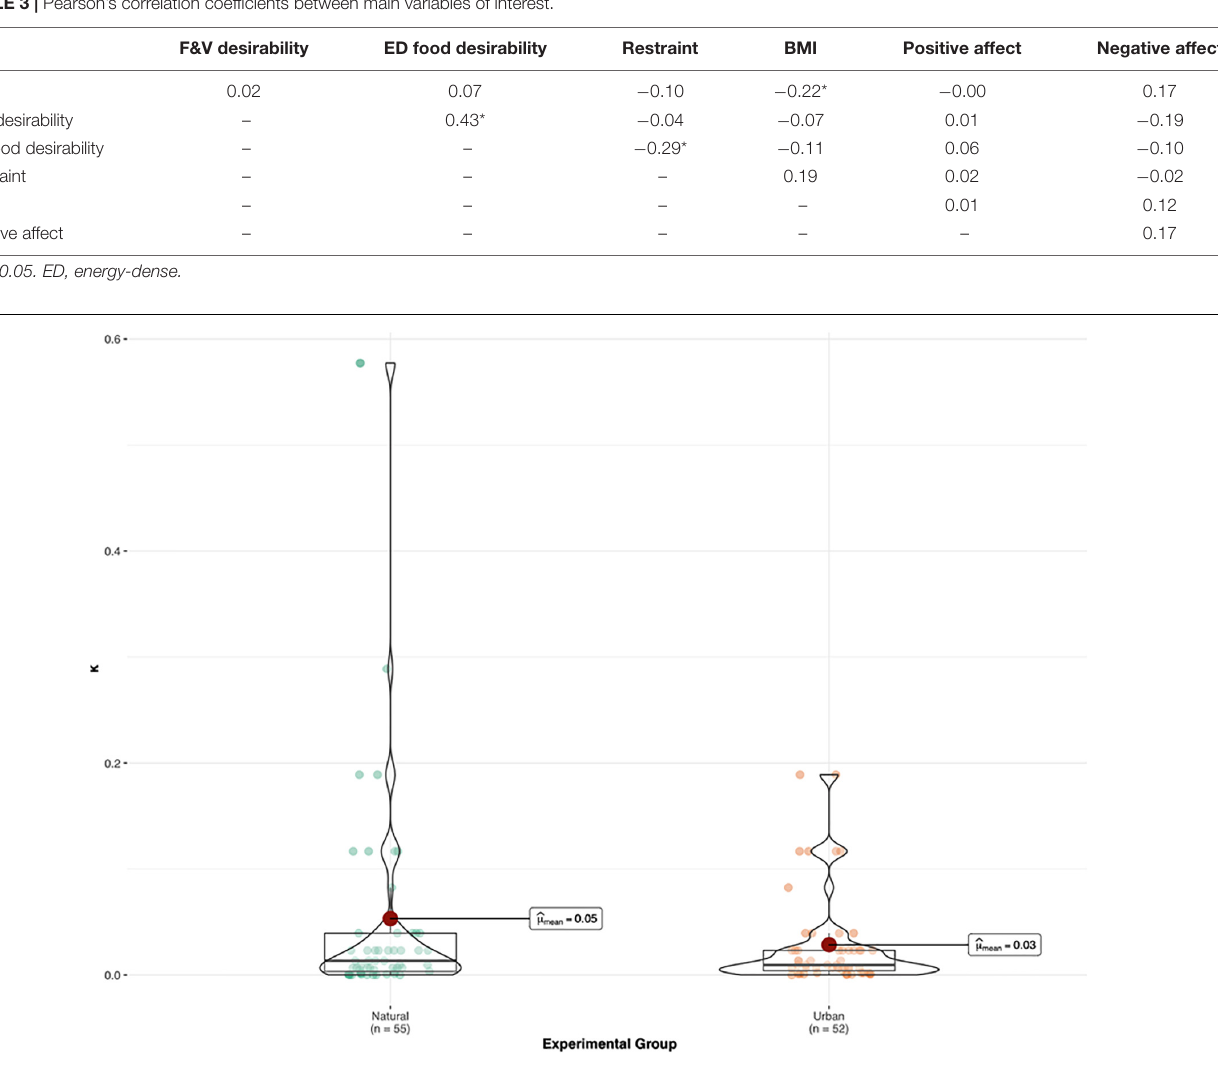
FIGURE 1 | Mean differences in k score (delay discounting) across experimental condition (natural vs. urban). A higher k indicates less willingness to wait for the delayed higher reward. For k , 1 outlier removed from each